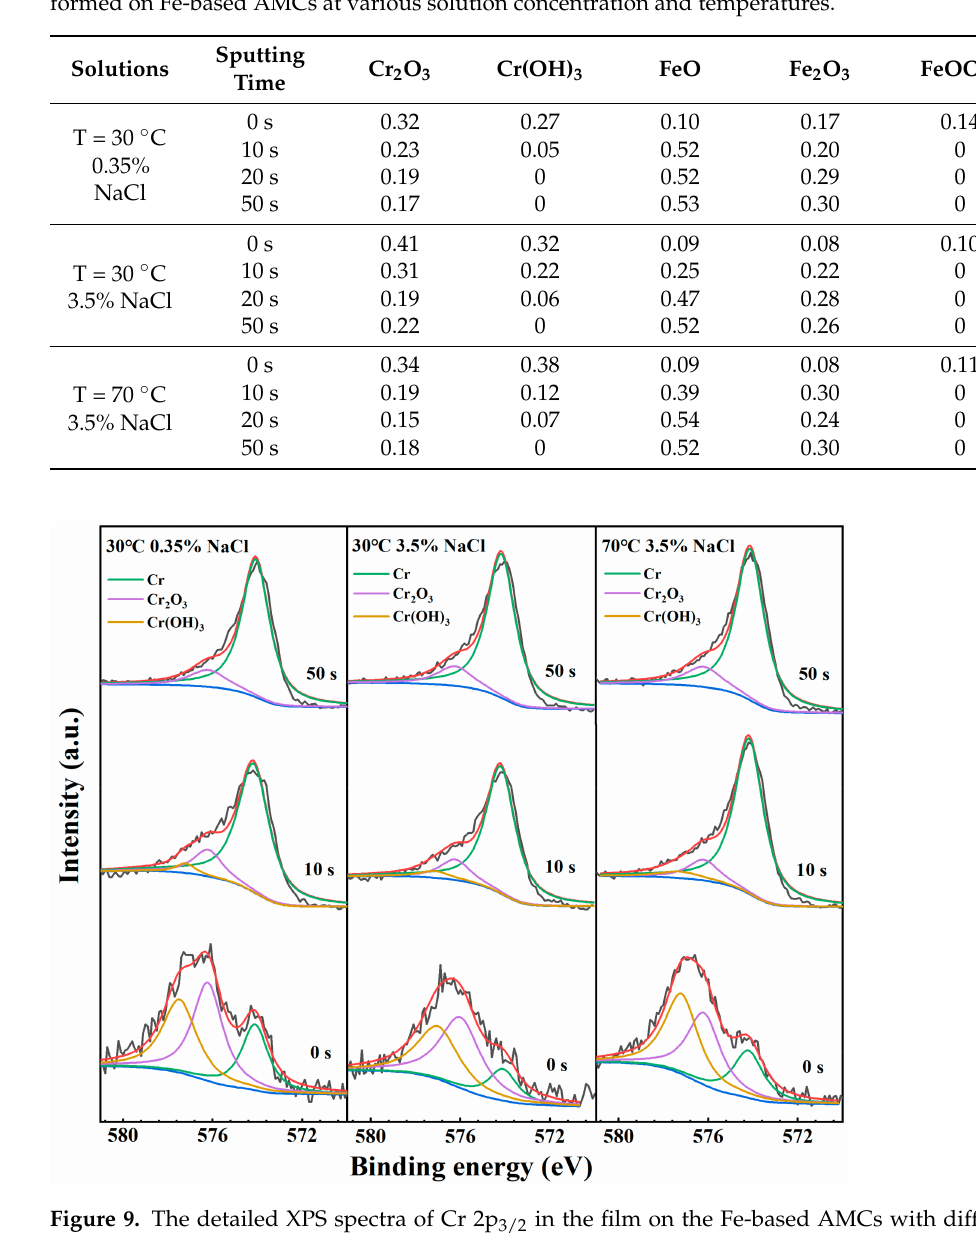
Table 4. XPS peak assignments and relative contents (at.%) for the composition of the passive films formed on Fe-based AMCs at various solution concentration and temperatures.